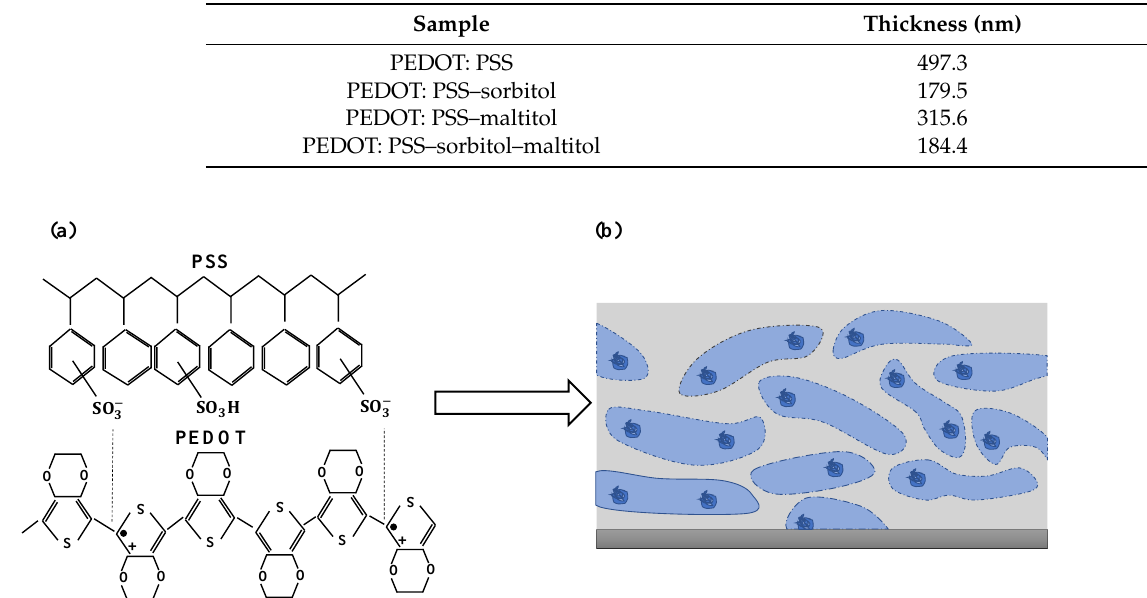
Figure 5. PEDOT: PSS structure and morphology: ( a ) PEDOT: PSS molecular structure and ( b ) re- sultant film with the PEDOT: PSS-rich (blue) and PSS-rich (grey) phases.